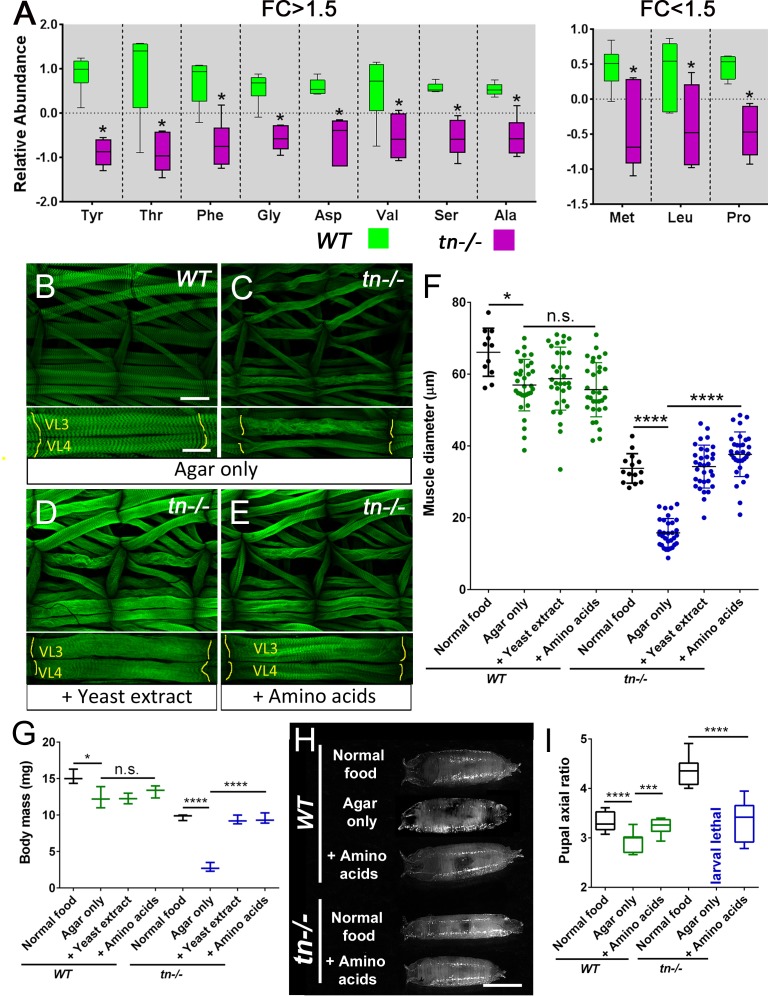
Amino acid supplementation is sufficient to improve tn-/- muscle mass.(A) Box and whisker plots showing the relative abundance of individual amino acids in L3 larvae with a FC >1.5 (left panel) or FC <1.5 (right panel) that are significantly reduced upon loss of TRIM32. N = 6. (B–E) Maximum intensity projections of WT (B) or tn-/- (C–E) L3 muscles stained for F-actin. Upper panel depicts two complete hemisegments and lower panel focuses on the VL3 and VL4 muscles. MASs are denoted by yellow lines. (B) An example of thinner WT musculature reared on agar as a sole nutritional source. (C) Muscles in larvae deficient for TRIM32 are substantially thinner when raised on agar alone. (D,E) Suppression of the reduced muscle diameter is observed in tn-/- muscles supplemented with total yeast extract (D) or amino acids (E) compared to tn-/- muscles alone. (F) Scatter plot showing the diameter of muscle VL3 in WT or tn-/- exposed to the indicated nutritional diets. N ≥ 32. (G) Average body mass measurements of WT or tn-/- L3 larvae. Ten individuals were weighed for each biological replicate that was performed in triplicate. (H) Representative pupal cases grown on the indicated diets. (I) The axial ratio (length/width) of pupal cases represented by box and whisker plots. N ≥ 10. Mean +/- SD. (****, p<0.001; *, p<0.05; n.s., not significant). Scale bars: 100 µm (A-D, upper panel), 50 µm (A-D, lower panel), 1 mm (H).